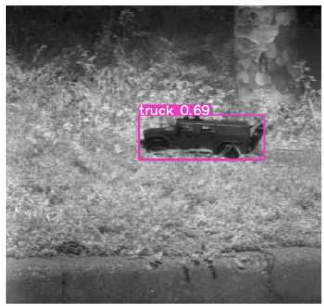
Figure 9. Test results of a Mengshi vehicle.